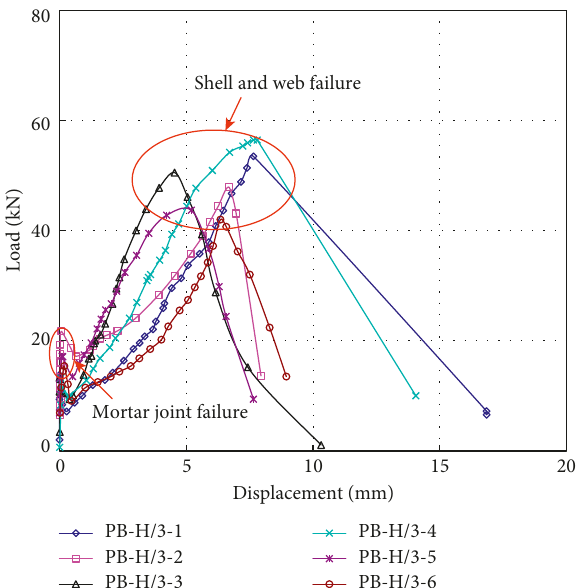
Figure 13: Load-displacement response of group PB-H/3.